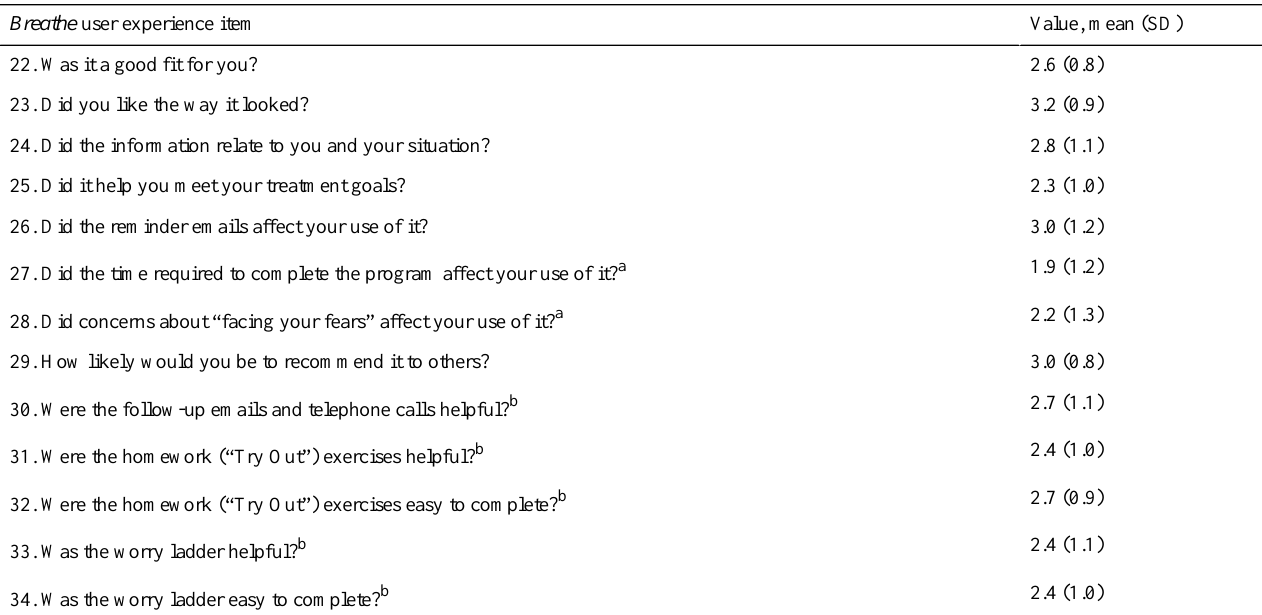
Table 8. Breathe respondents’ratings (n=81) from the User Experience Questionnaire for Internet-based Interventions.